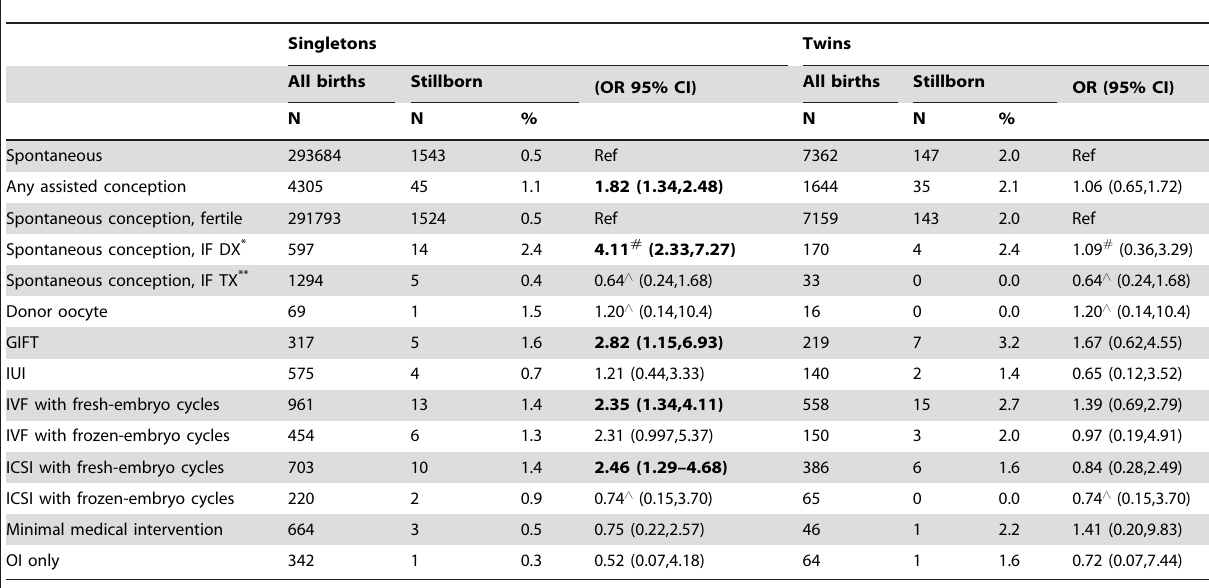
Table 2. Stillbirth among singletons and twins by mode of